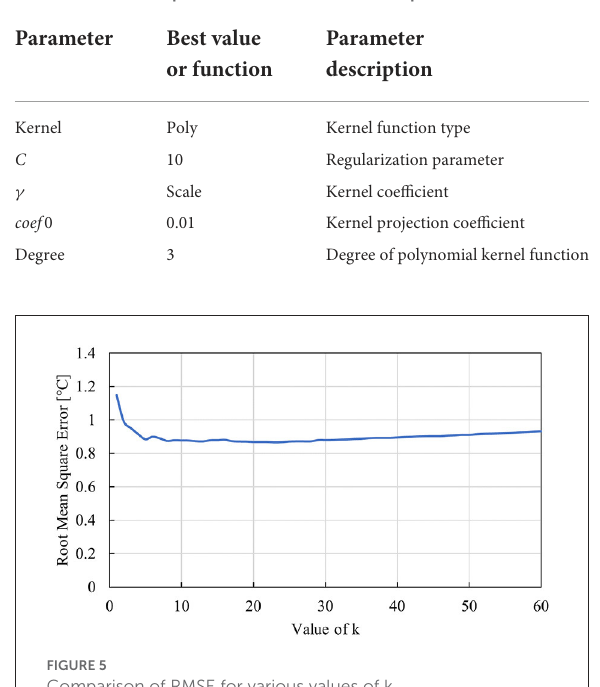
TABLE 3 Best SVM parameters identified for the provided dataset.